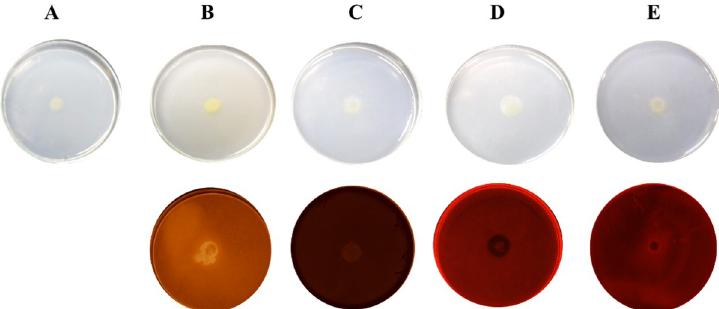
Fig 3. BHB agar medium plates supplemented with different substrates (10.0 g L − 1 ), resulting from cultivation after 96 hours, respectively, (A) Glucose, (B) Galactomannan (Gum Locust bean from Ceratonia siliqua ), (C) Carboxymethylcellulose (CMC), (D) Aloe vera and (E) Starch. The lower plates depict the B-E treatments stained with Congo Red (1%).